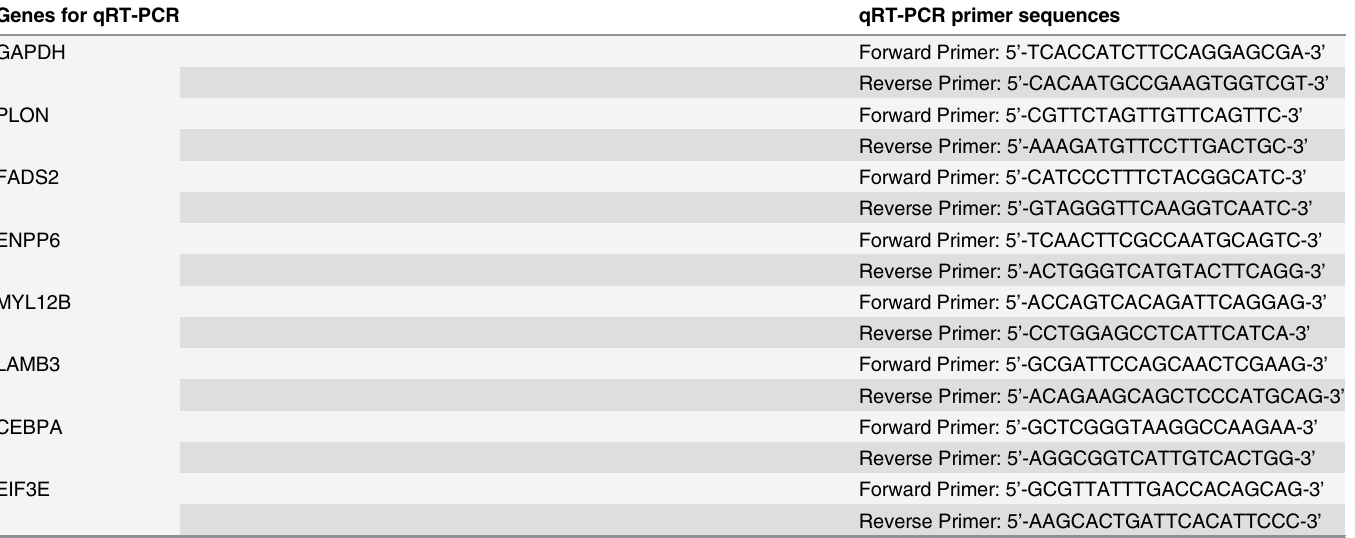
Table 4. Primers used in qRT-PCR for the validation of differentially expressed genes. Genes for qRT-PCR